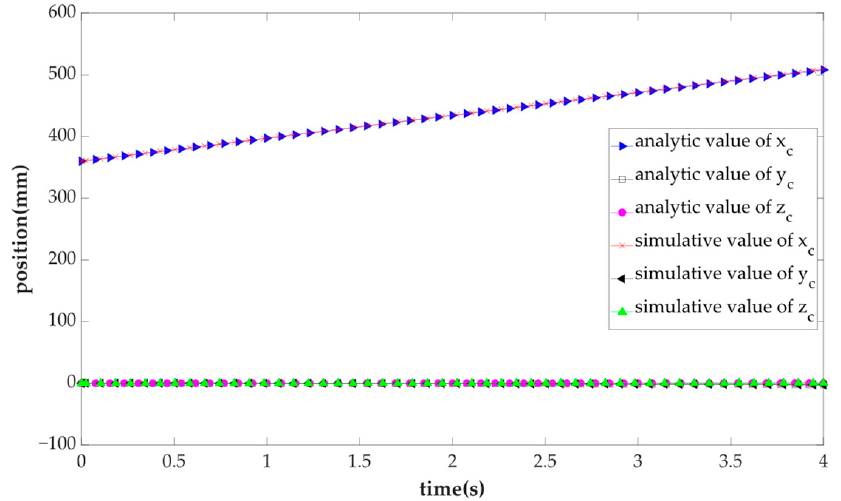
Figure 9. The comparison between analytic results and simulative results of positional parameters of m . In addition, given the two groups of actuator lengths l i ( i = 1, 2, 3 ) , we can obtain two groups of analytic results using the positional posture model. The comparison between analytic results and simulative results is shown in Table